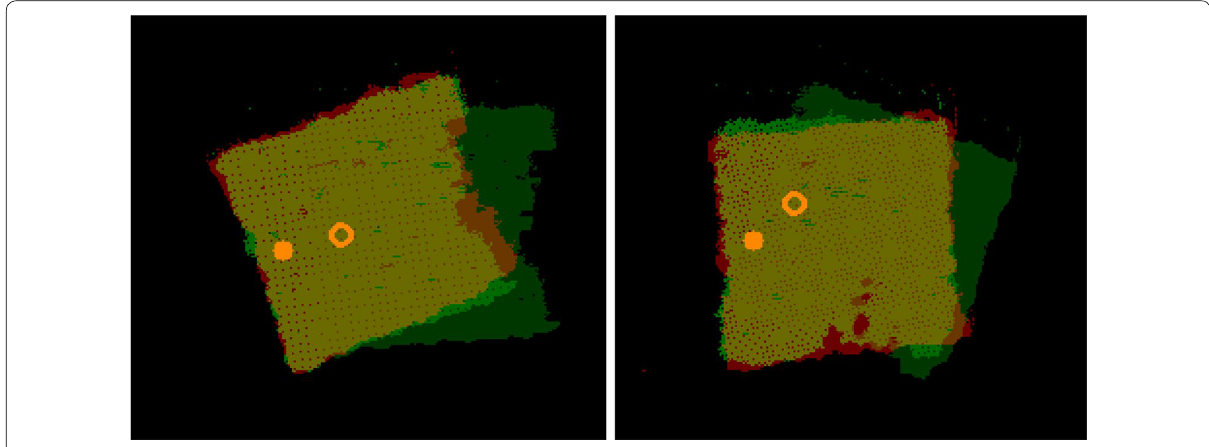
Fig. 11 Examples of fine adjustment for grasp point